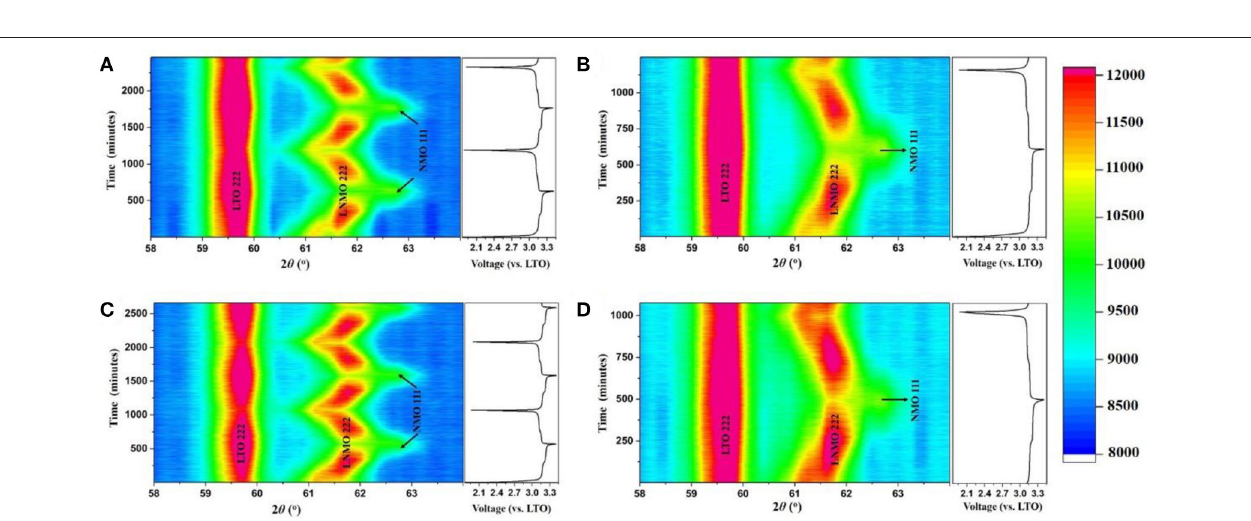
FIGURE 3 | (A) Cycling performance and coulombic efficiency of LTO and AlF 3 -coated LTO at 1C up to 260 cycles; (B) rate performance of LTO and AlF 3 -coated LTO; 1st, 50th, and 200th charge-discharge curves of (C) LTO and (D) AlF 3 -coated LTO at 1C. The capacity of AlF 3 -coated LTO sample is measured for the composite, including electrochemically active LTO and inactive AlF 3 .